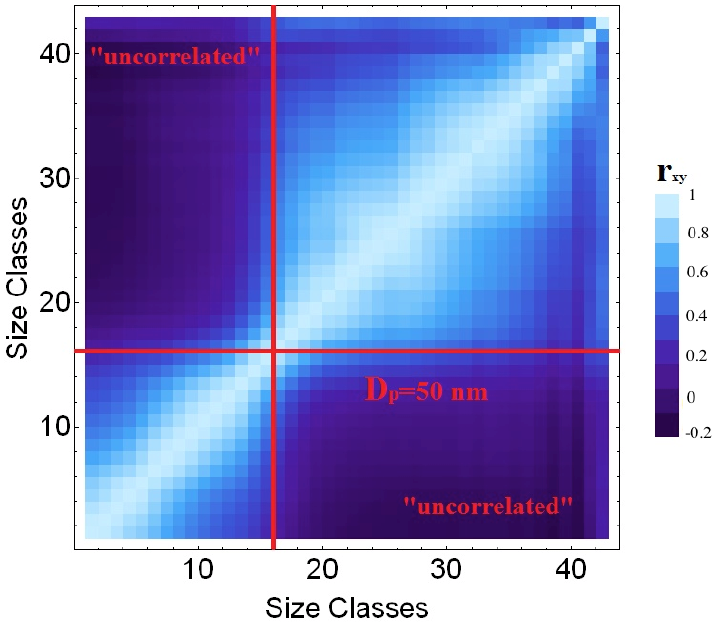
Figure 2. Time correlation between the 43 different channels of the SMPS. The diagonal has r = xy